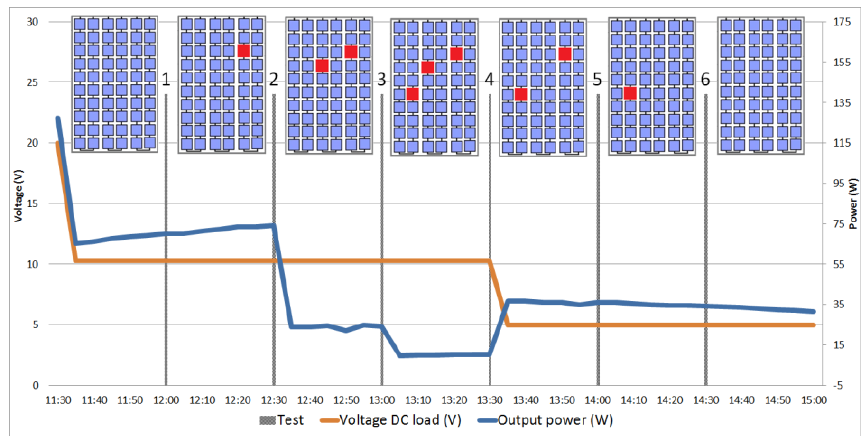
Figure 11. Programmable DC electronic load voltage imposed and output power in test 3.